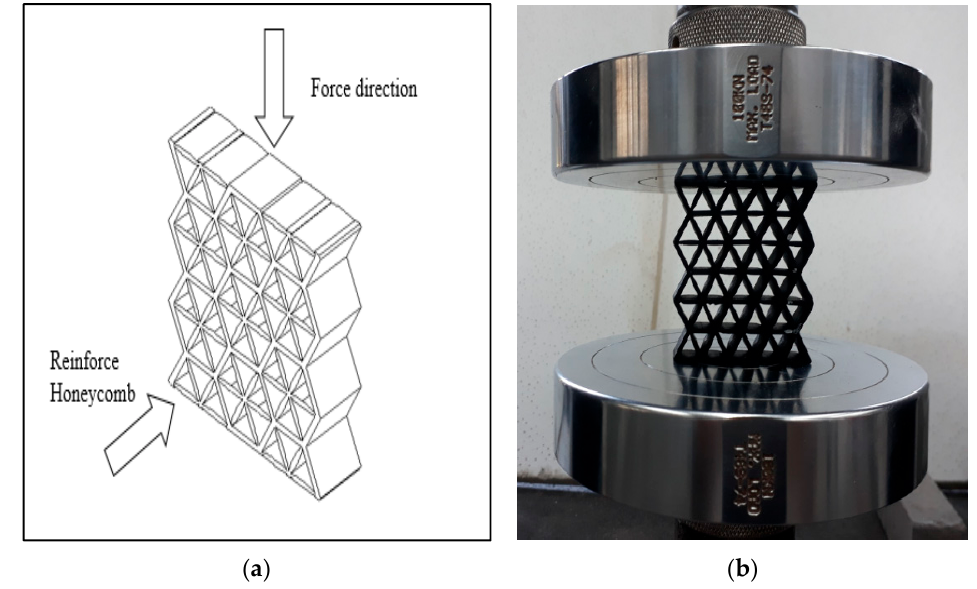
Figure 4. The final 3D printed specimens for ( a ) cell size 20 mm, thickness 2.5 mm, ( b ) cell size 25 mm, thickness 2 mm and ( c ) cell size 30 mm, thickness 1.5 mm.